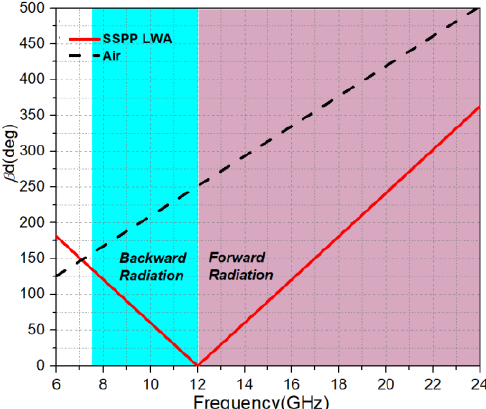
Figure 7. Dispersion diagram of the proposed SSPP leaky-wave antenna.